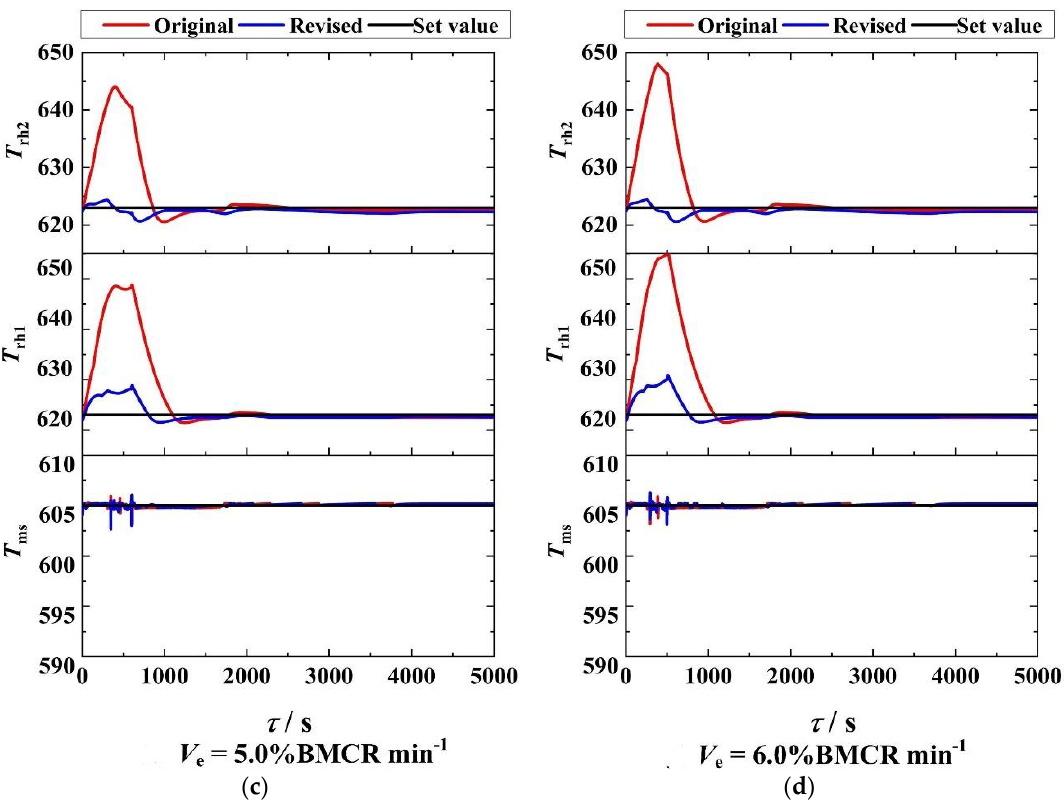
Figure 10. Real-time steam temperatures (rh2: reheater 2, rh1: reheater 1, ms: main steam) with original and revised logics (BMCR: boiler maximum continuous rate): ( a ) During the loading-up process with 5% BMCR/min rate; ( b ) During the loading-up process with 6% BMCR/min rate; ( c ) During the loading-down process with 5% BMCR/min rate; ( d ) During the loading-down process with 6% BMCR/min rate; Reprint with permission [81]; 2020, Elsevier.